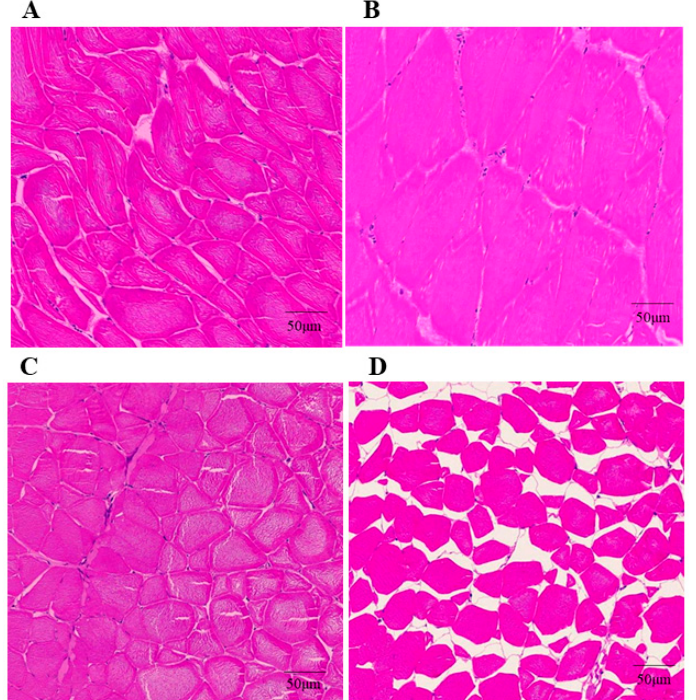
Figure 4. The effects of Gomisin J and Pim on triploid crucian carp histological characteristics of muscle fibers. ( A ) H&E staining (original magnification × 200) exhibits a distribution of muscle fiber and muscle fiber space 15 days after PBS injection. ( B ) H&E staining (original magnification × 200) exhibits a distribution of muscle fiber and muscle fiber space 15 days after Gomisin J injection. ( C ) H&E staining (original magnification × 200) exhibits a distribution of muscle fiber and muscle fiber space 9 days after PBS injection. ( D ) H&E staining (original magnification × 200) exhibits a distribution of muscle fiber and muscle fiber space 9 days after Pim